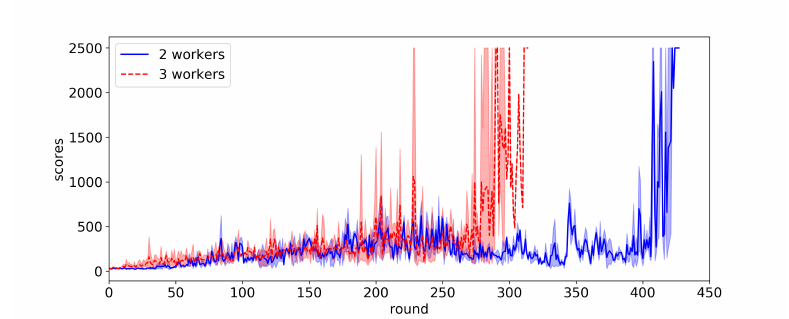
Figure 6. Comparison of learning speed in terms of the number of